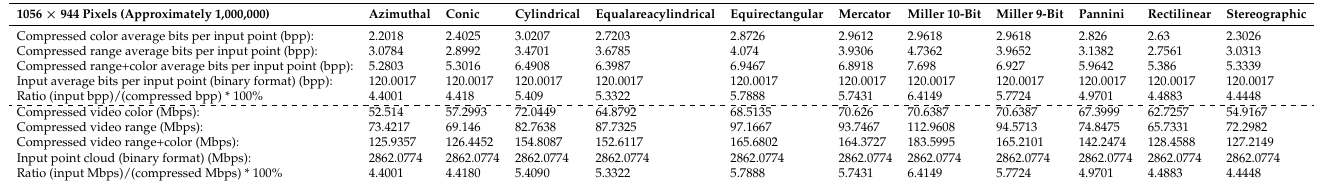
Figure 13. Average ratio of the input file sizes and the color and range compressed video file sizes, created from the panorama images, using point cloud Longdress . Ratio is presented for all cases, e.g., for 1,000,000, 1,500,000 and 2,000,000 points. Table 1. Information about the compressed file sizes for different projection types, with projection area of 1056 × 944 pixels (approximately 1,000,000).